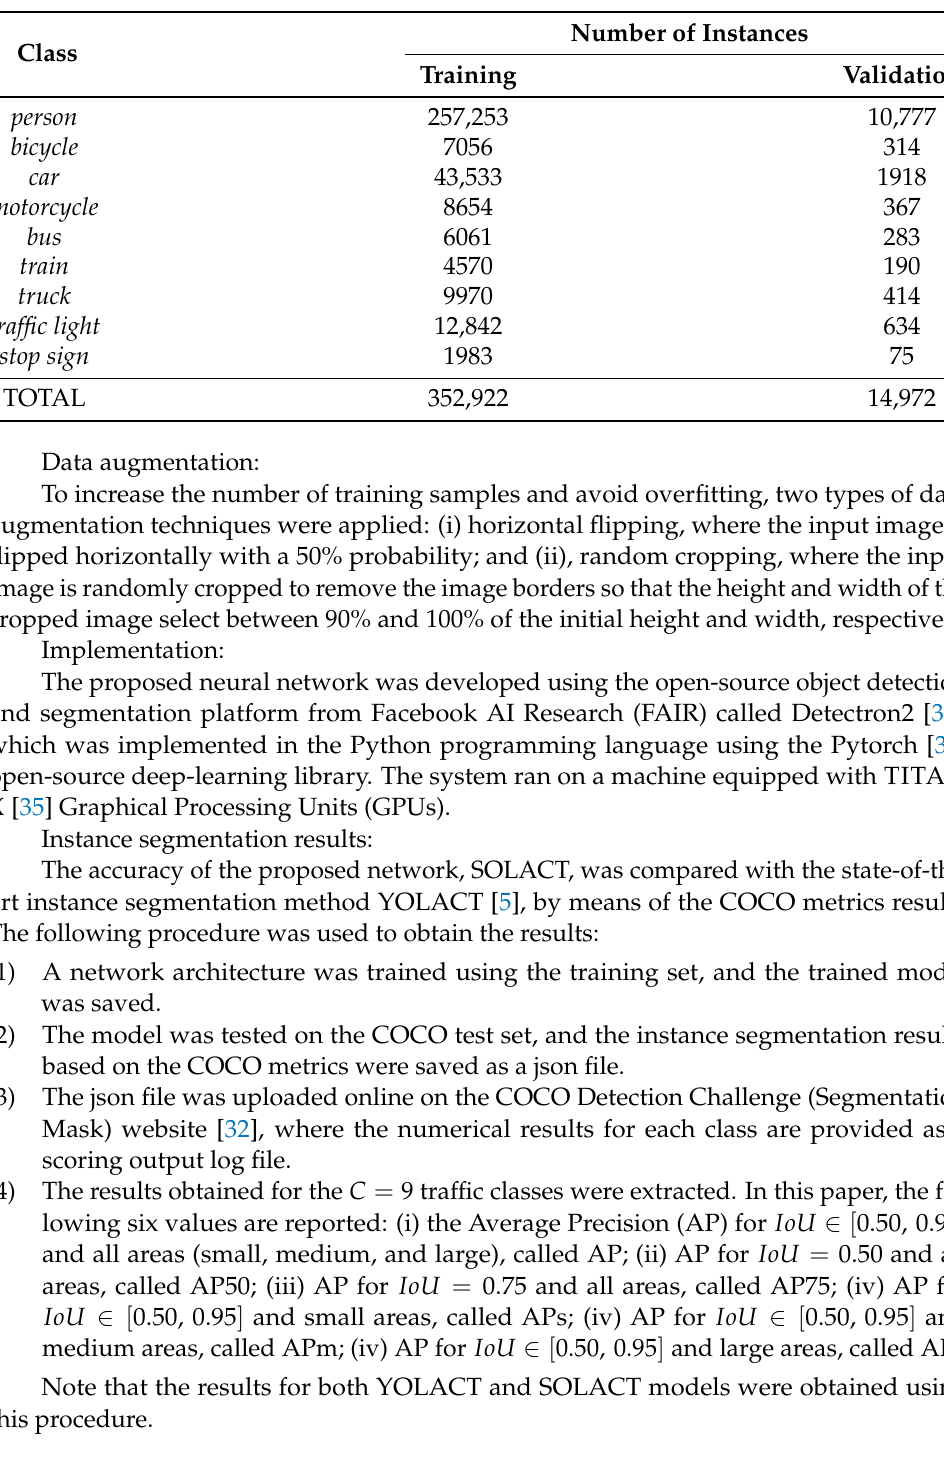
Table 1. Number of instances per traffic class extracted from the COCO dataset